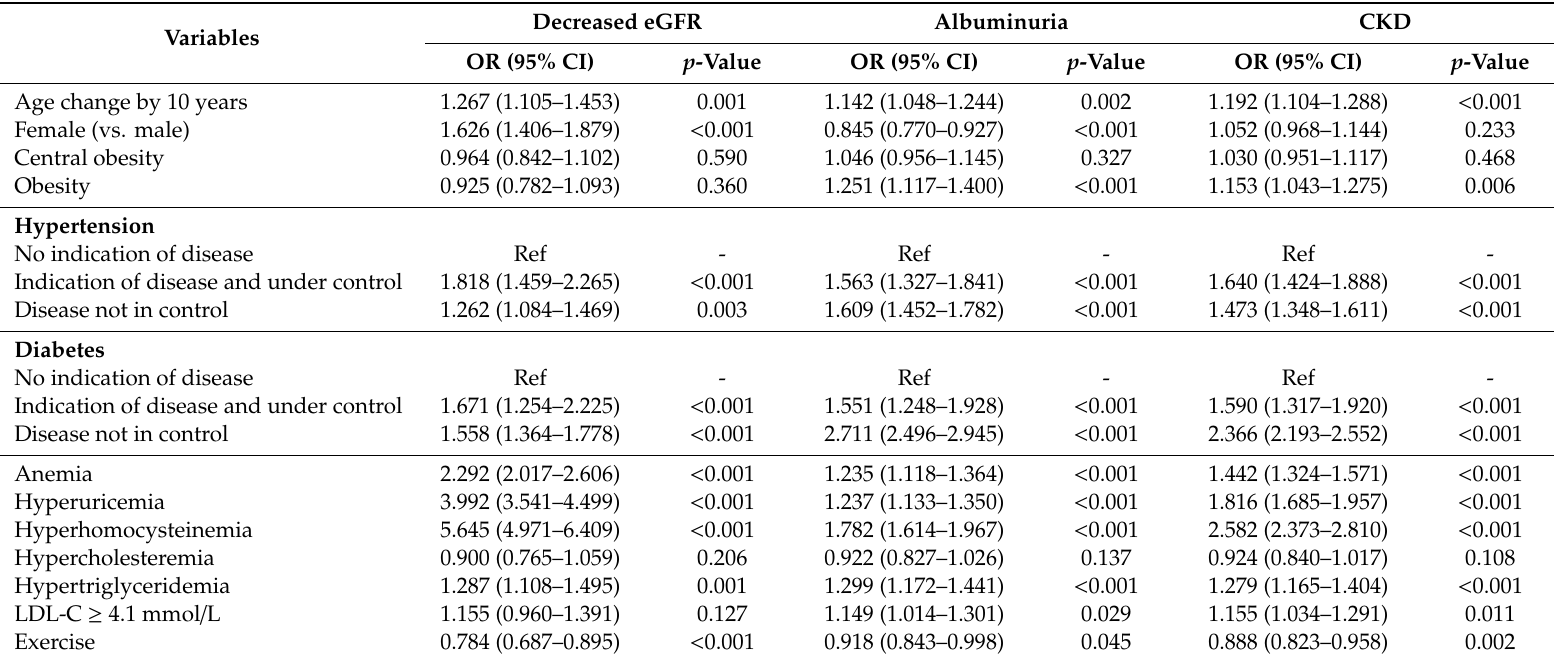
Table 4. Adjusted odds ratios for indicators of kidney function by risk